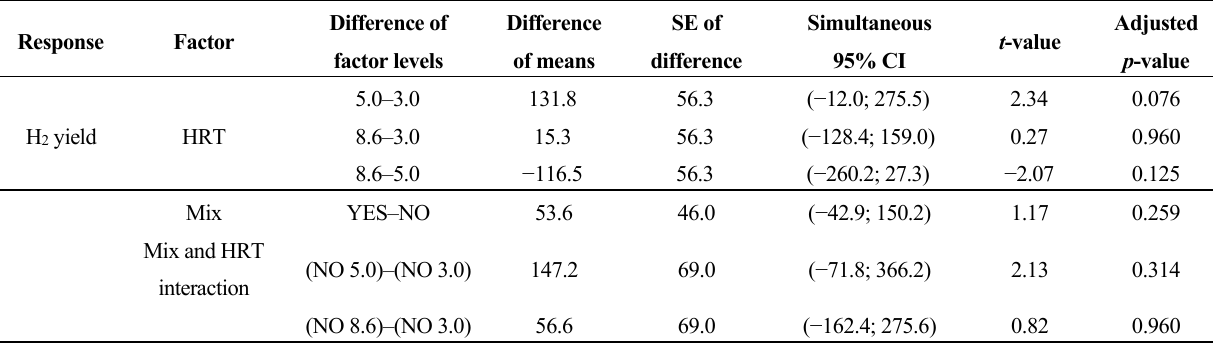
Table 4. Tukey pairwise comparisons: response = H 2 yield, acetic acid production; factor = HRT, mix and mix and HRT interaction